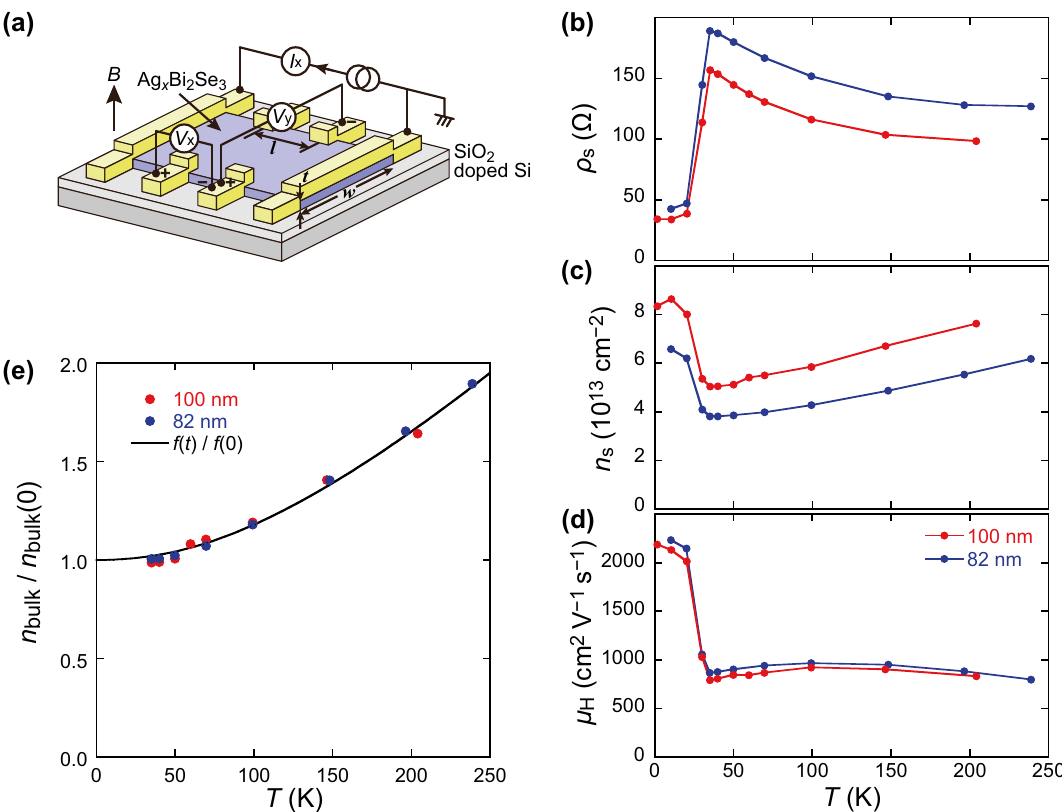
Figure 3. ( a ) Schematic configuration for Hall effect measurement. Temperature dependence of ( b ) sheet resistance, ( c ) electron density per unit area, and ( d ) Hall mobility. Red and blue data were obtained from the devices with 100 and 82 nm thickness, respectively. The data in ( c ) from the device with 82 nm thickness was used in our previous report 19 . ( e ) Temperature dependence of bulk carrier density normalized by the value at zero temperature. The data at the semiconducting state ( T ≥ 35 K) are